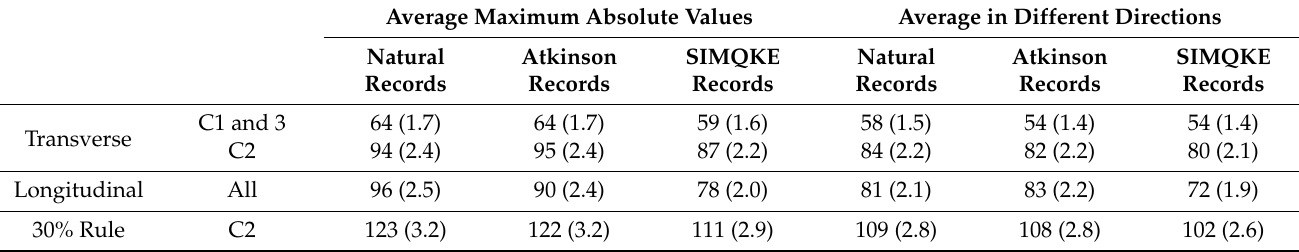
Table 5. Summary of the mean maximum absolute displacements (mm) for columns C1, C2 and C3 using 2D analysis for the regular bridge with mean ductility demands given in